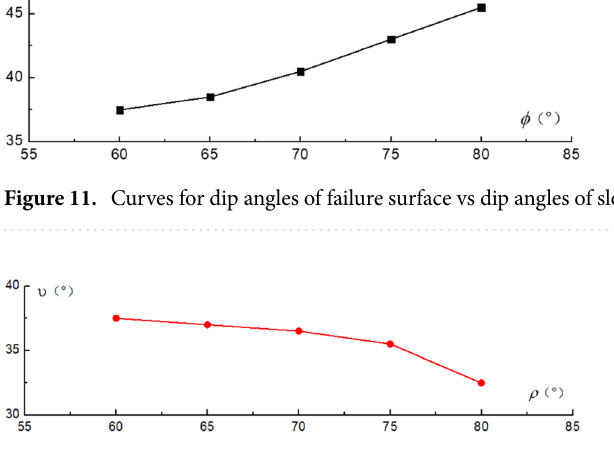
Figure 12. Curves for dip angles of failure surface vs dip angles of rock